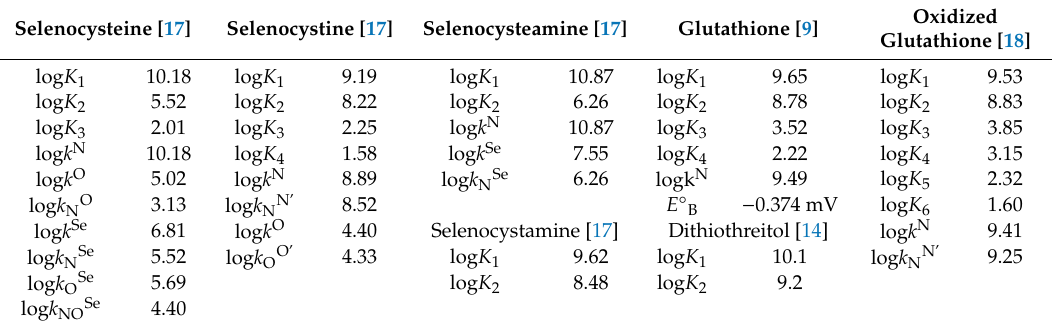
Table 1. Protonation constant and standard redox potential values of the studied compounds from previous works. See Figures 4 and 5 for the description of the equilibrium